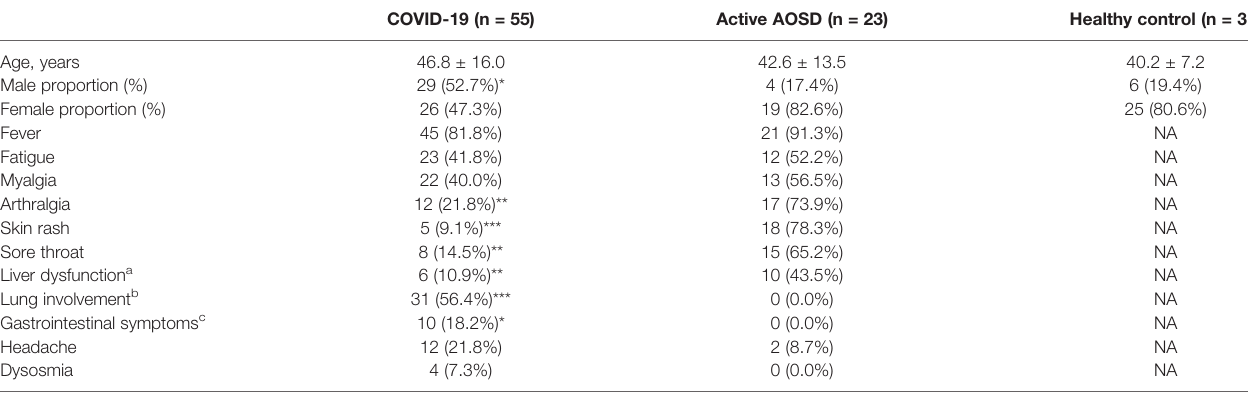
TABLE 1 | Demographic data and clinical manifestations in COVID-19 patients, active AOSD patients, and healthy